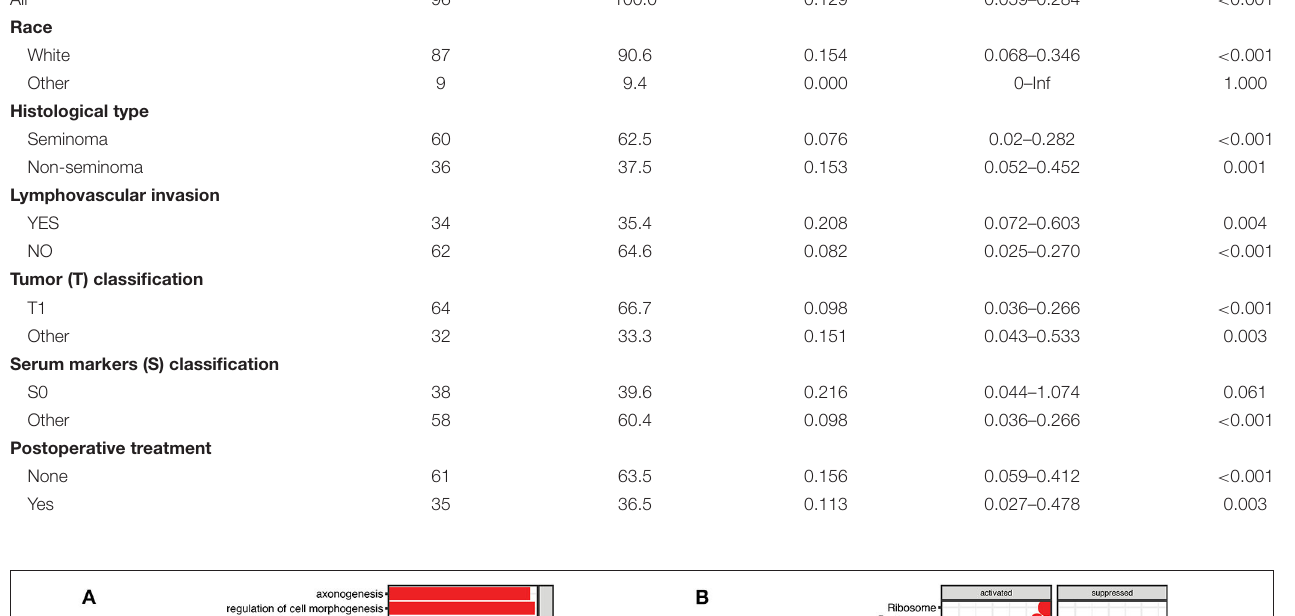
TABLE 4 | Validation of the robustness of the prognostic value in in different subgroups. Variable